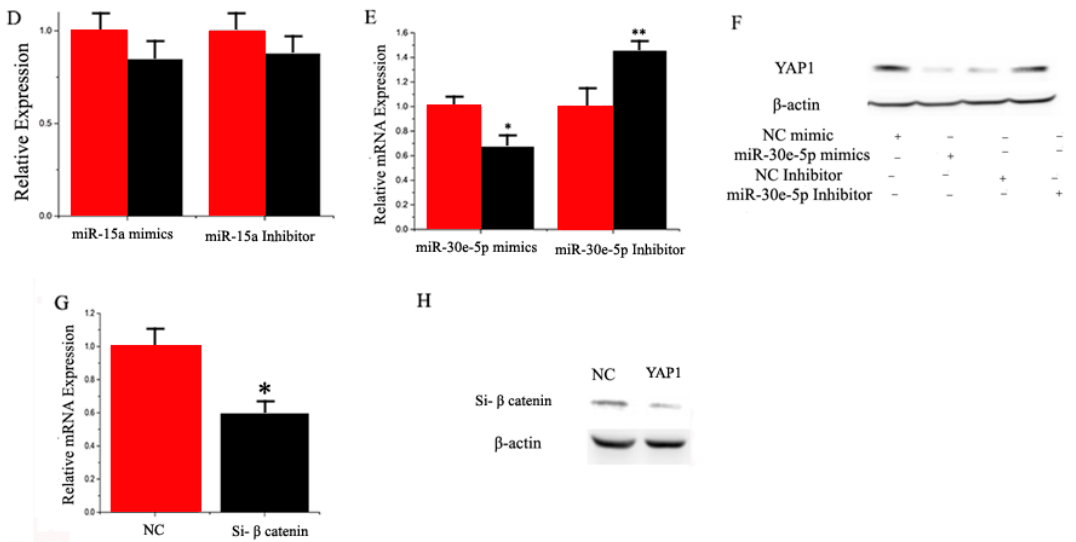
Figure 4. ( A ) RT-qPCR quantification of the β -catenin expression level ( n = 6). Red bars represent the negative control; black bars represent miR-30e-5p mimic or inhibitor; ( B ) The effect of miR-30e-5p mimicking and inhibiting β -catenin protein expression was evaluated by Western blot analysis in GMEC; ( C ) GMEC were transfected with miR-30e-5p mimic or inhibitor, and the miR-15a expression level was quantified by RT-qPCR ( n = 6). Red bars represent the negative control; black bars represent miR-30e-5p mimic or inhibitor; ( D ) GMEC were transfected with miR-15a mimic or inhibitor, and the miR-30e-5p expression level was quantified by RT-qPCR ( n = 6). Red bars represent the negative control; black bars represent miR-15a mimic or inhibitor; ( E ) the YAP1 expression level was quantified by RT-qPCR ( n = 6). Red bars represent the negative control; black bars represent the miR-30e-5p mimic or inhibitor; ( F ) The effect of miR-30e-5p mimicking and inhibiting YAP1 protein expression was evaluated by Western blot in GMEC; ( G ) GMEC were transfected with Si-NC (60 nM) or SiRNA- β -catenin (60 nM) for 48 h, the mRNA expression of YAP1 was quantified by RT-qPCR ( n = 6); ( H ) The effect of Si-NC (60 nM) or SiRNA- β -catenin (60 nM) for 48 h on YAP1 protein expression was evaluated by Western blot in GMEC. All experiments were duplicated and repeated three times. Values are presented as means ± standard errors, * p < 0.05; ** p < 0.01.